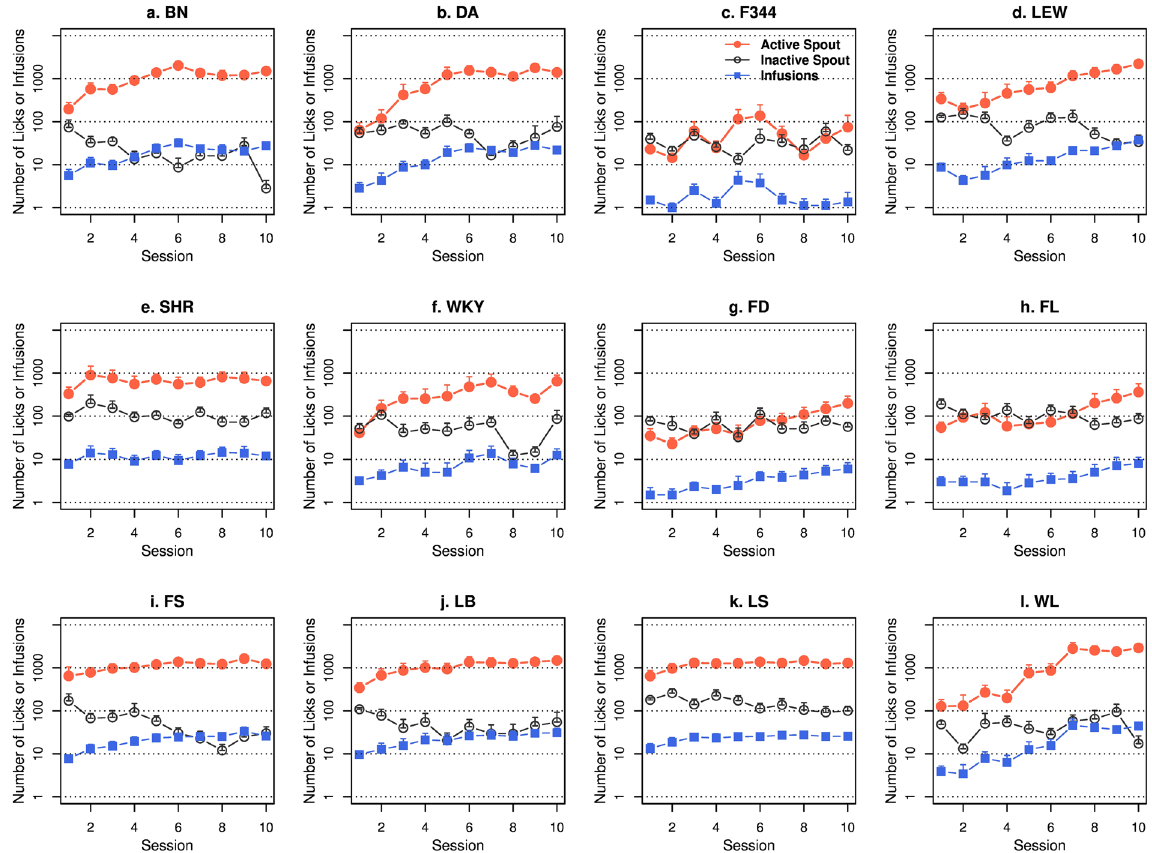
Figure 1. Female adolescent rats from 12 isogenic strains were tested by using the socially acquired nicotine (15 μ g/kg/inf) IVSA procedure. See Methods for a detailed description of the procedure. A logarithmic scale is used for the